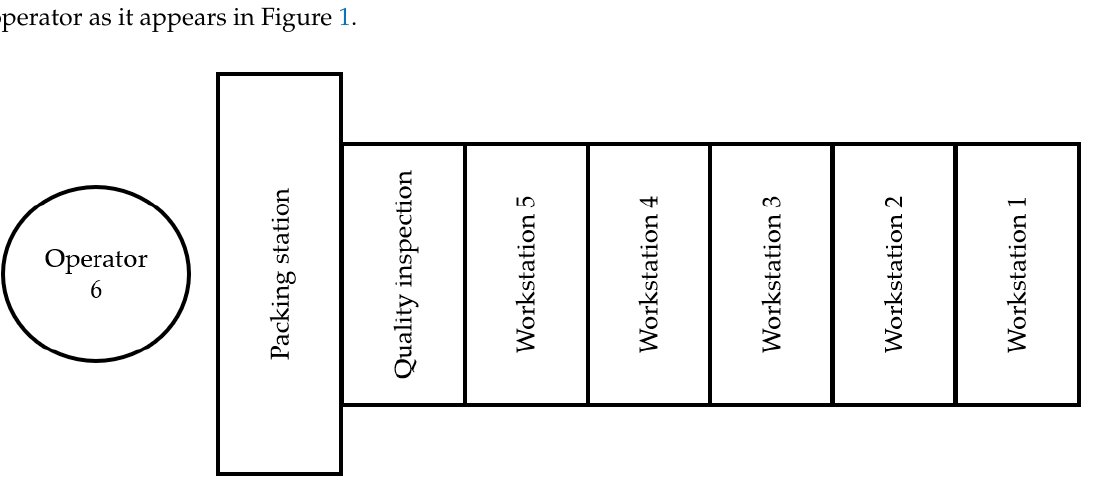
Figure 1. Current layout distribution for an assembly line. Table 1. Difference in production and equivalence in extra work time.